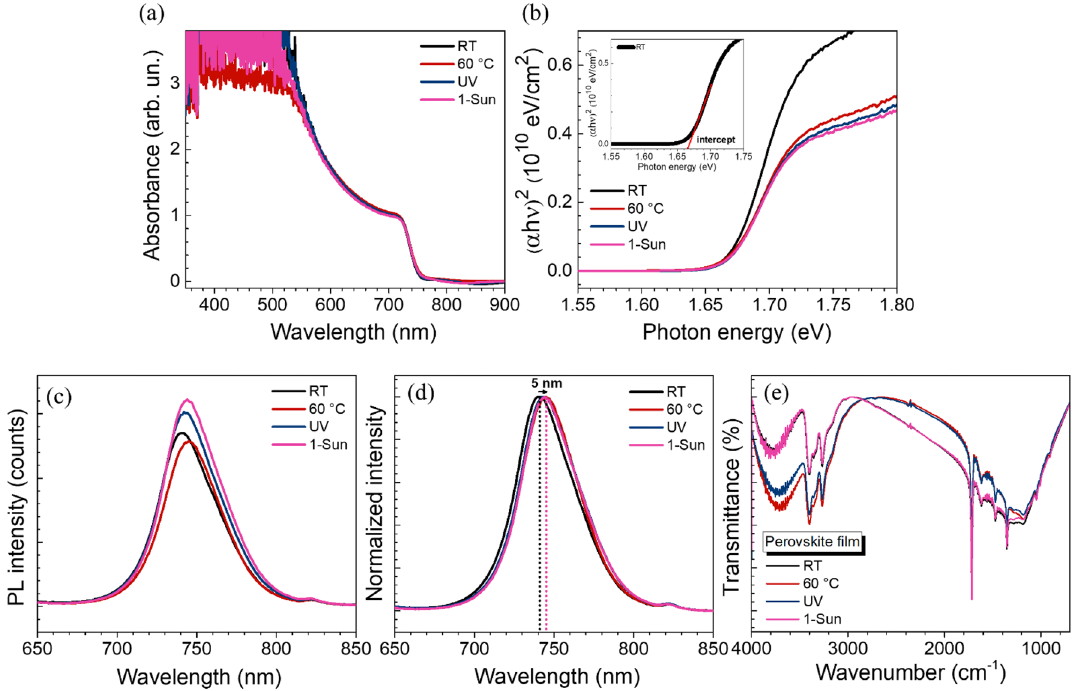
Figure 3. ( a ) UV–Visible absorption spectra. ( b ) Optical bandgap (E g ). ( c ) Steady state PL emission spectra ( d ) Normalized PL emission intensity spectra. ( e ) FTIR spectra for films with RT, 60 °C, UV, and